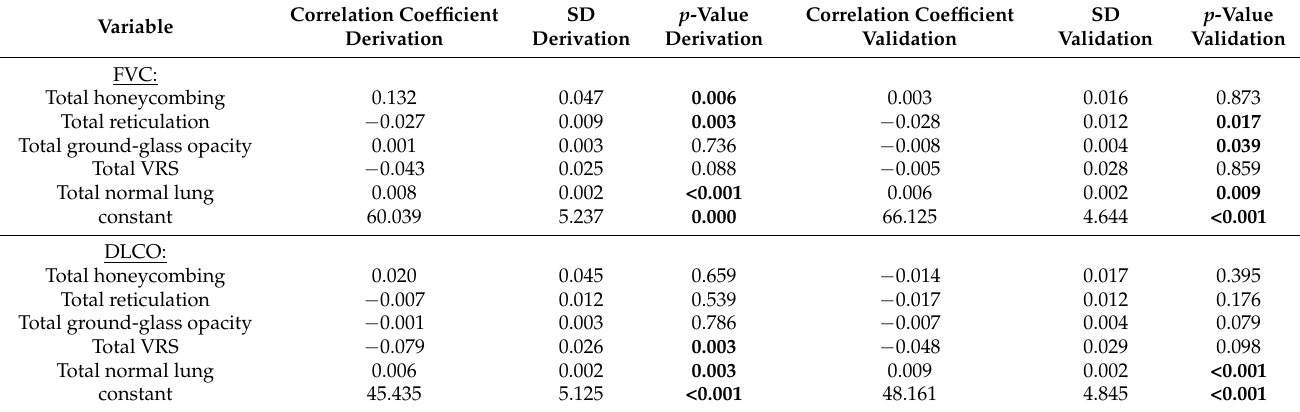
Table 4. Multivariable linear correlation analysis of CALIPER variables relative to percent predicted forced vital capacity (FVC) and diffusing capacity of the lungs for carbon monoxide (DLCO) across two tertiary medical centers (labeled deri- vation and validation).